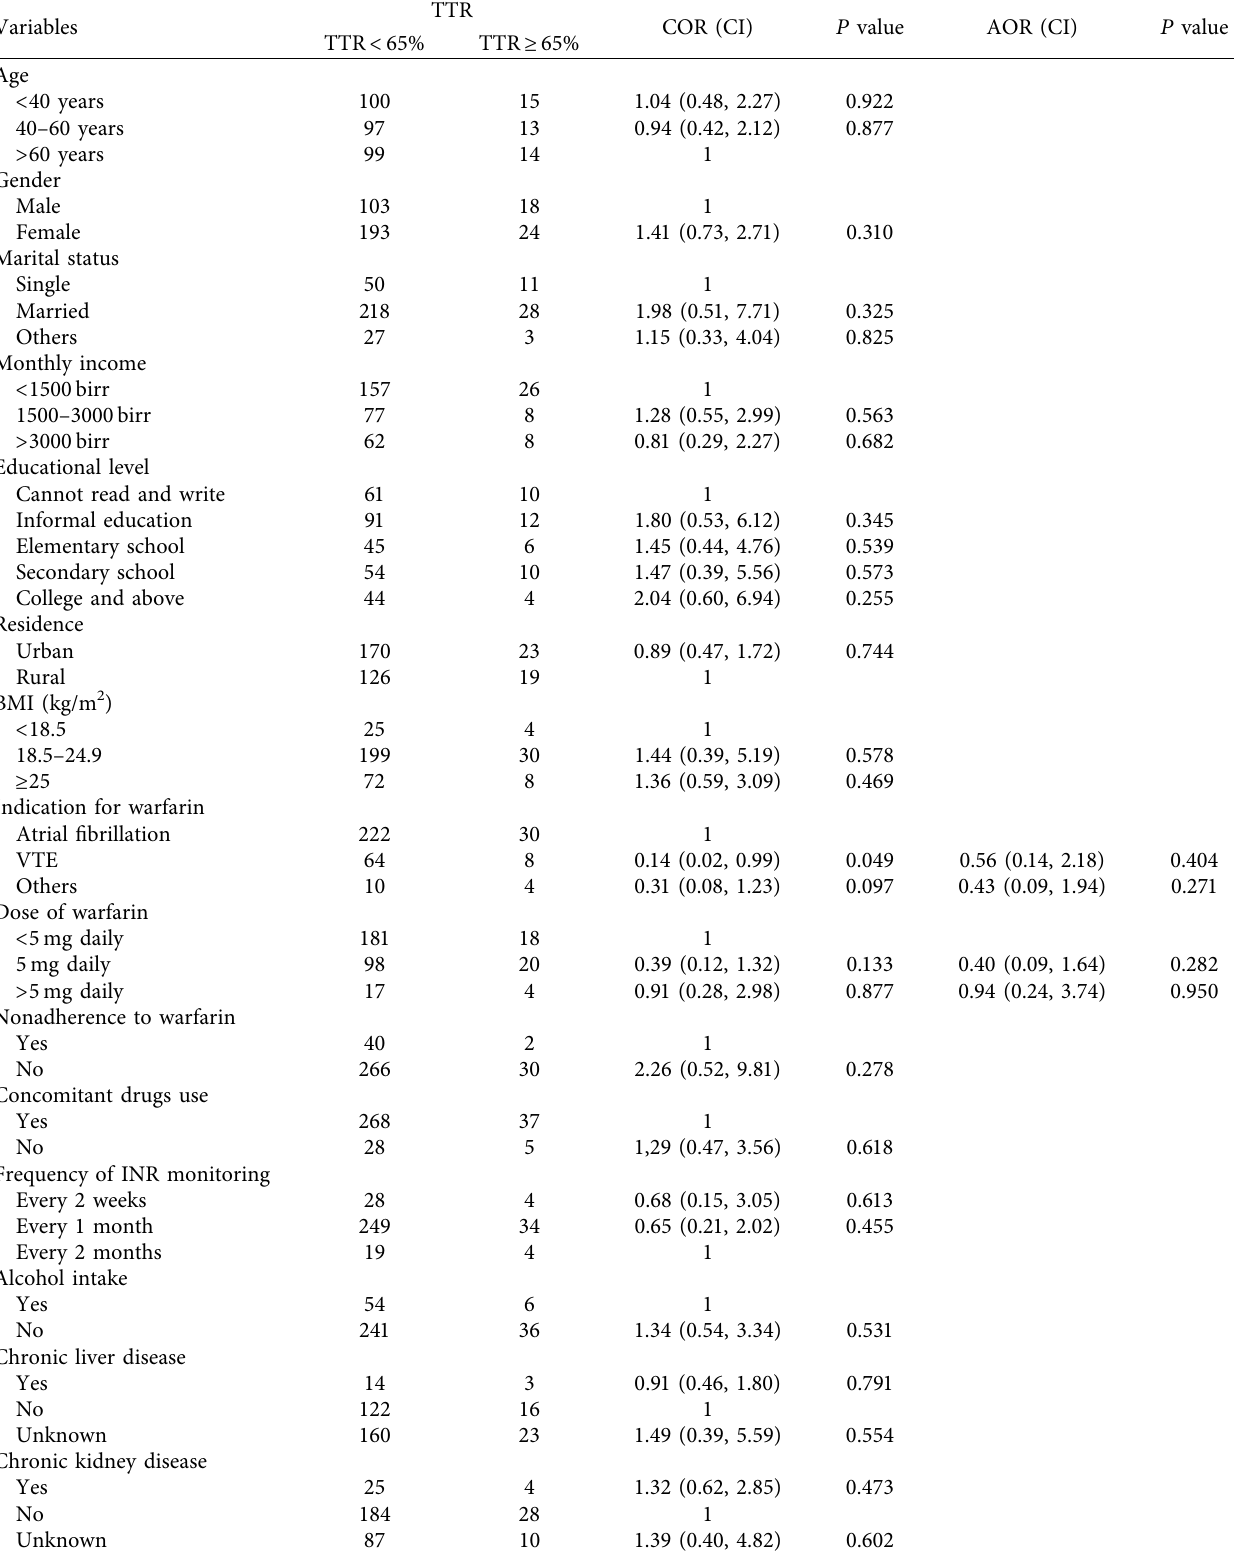
Table 3: Bivariate and multivariate logistic regression analyses of time spent within the therapeutic INR range (TTR) among patients taking warfarin in University of Gondar, Northwest Ethiopia, from November 1, 2019, to October 31, 2020 ( n �